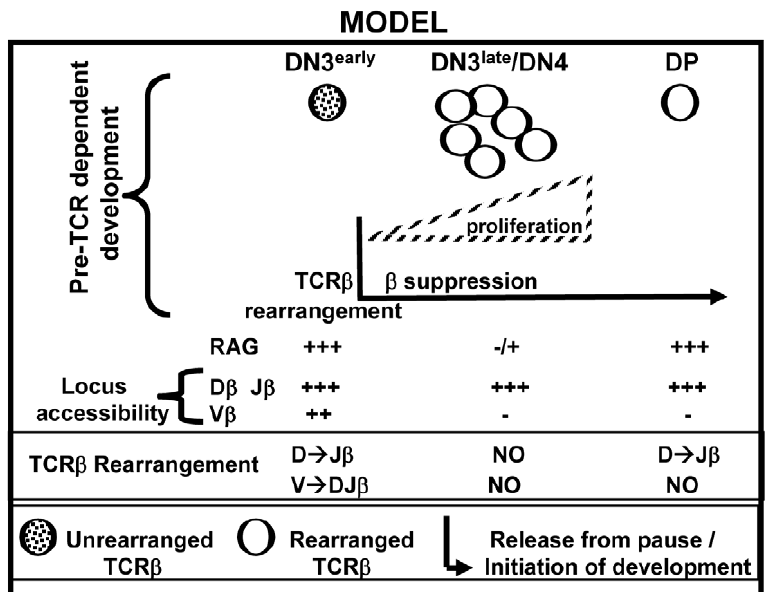
Figure 7. Model: The requirement for pre-TCR signaling enforces an essential pause in DN cell development.